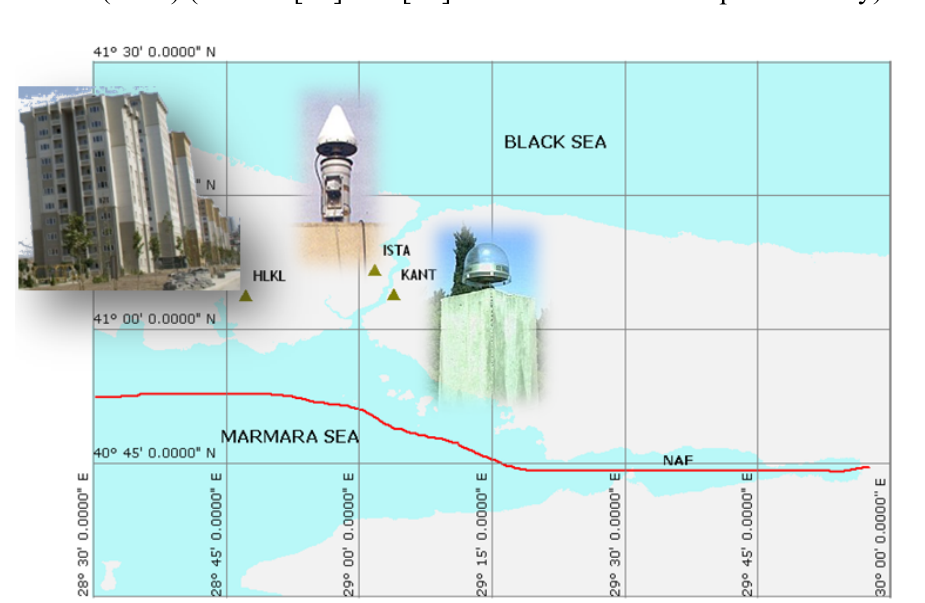
Figure 3. Locations of the tall building (HLKL) and the geodetic network stations (ISTA and KANT) in Istanbul. The red line indicates the approximate location of the